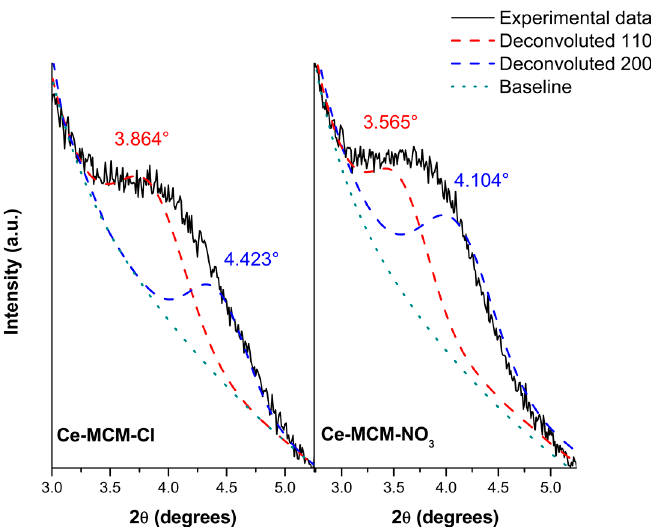
Figure 2. Deconvolution of the overlapped XRD reflections and their 2 θ positions for Ce-MCM-Cl and Ce-MCM-NO 3 materials.